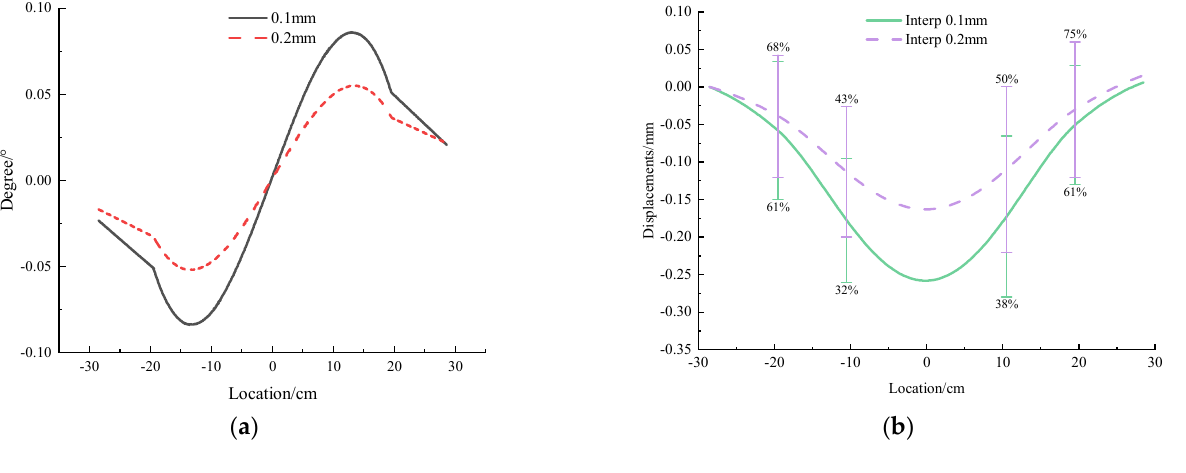
Figure 9. Angle and displacement curve of steel tunnel with 0.1 mm and 0.2 mm thickness under concentrated load. ( a ) Angle. ( b ) Displacement.